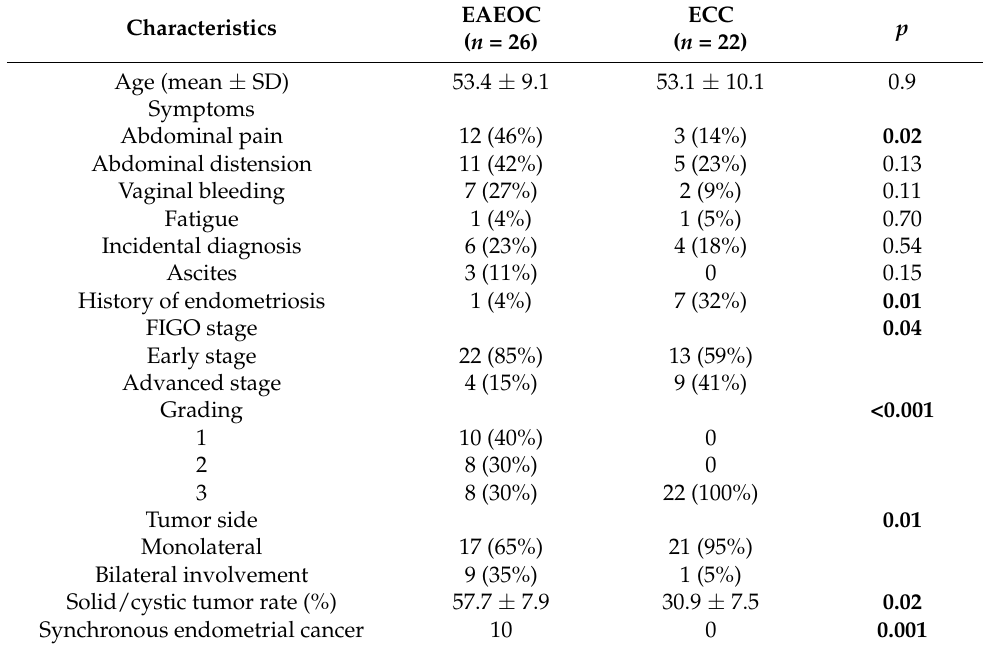
Table 1. Clinical and pathological characteristics of endometriosis-associated ovarian tumors.